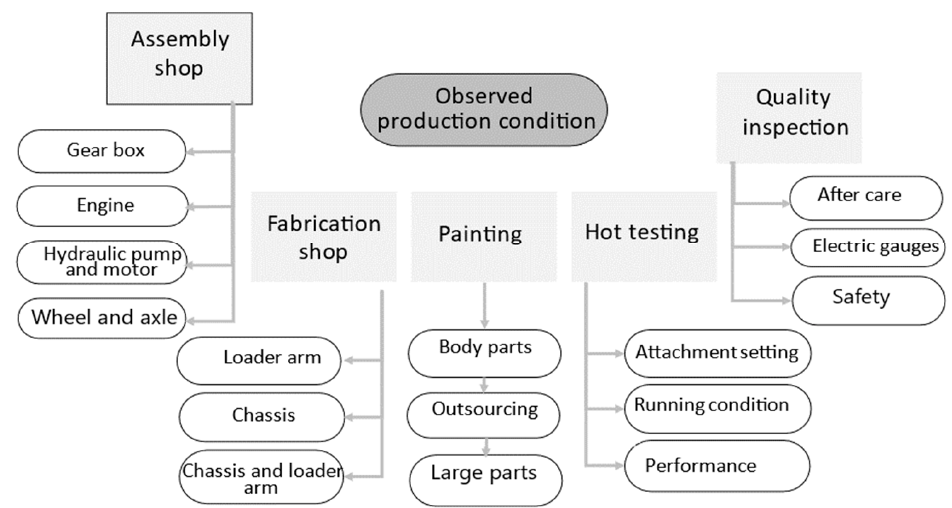
Figure 9. Present production planning found in industry A.